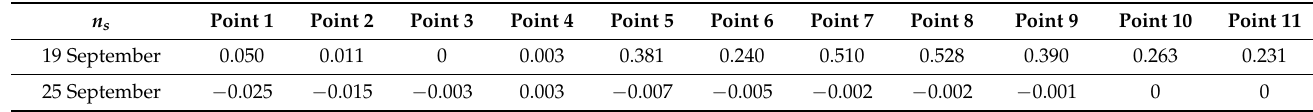
Table 2. Summary n s values of the points along the talweg.